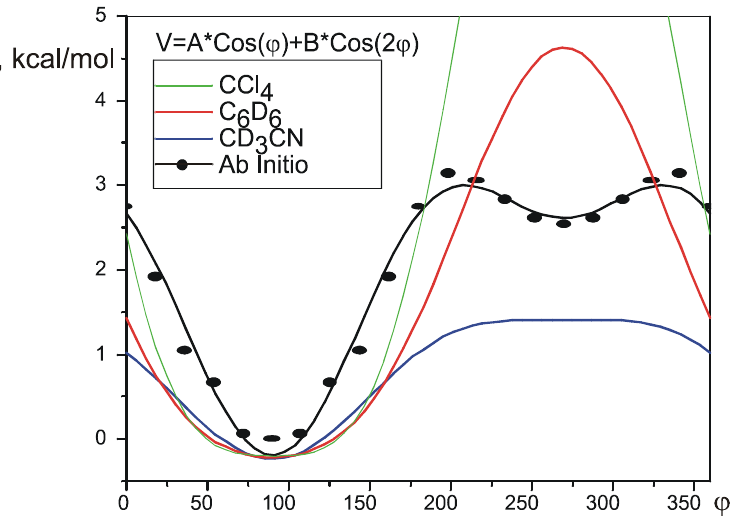
Figure 7. Pseudorotation potential for